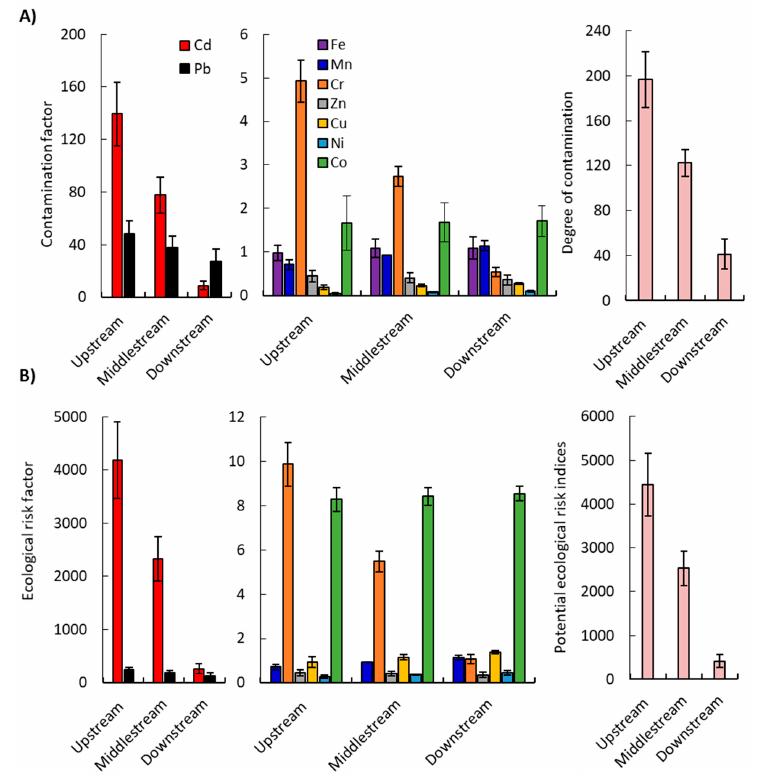
Figure 3. ( A ) The contamination factors and degree of contamination of heavy metals in the sediment samples from different locations (up-, middle- and downstream) of the studied drains in the Nile Delta. ( B ) Ecological risk factor and potential ecological risk index.